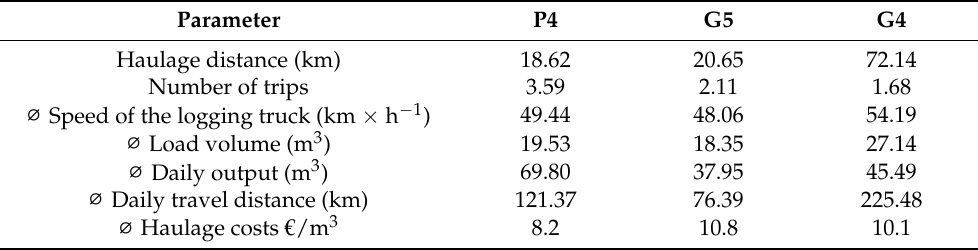
Table 3. Mean values of selected operational parameters of the Scania P450 (P4), G500 (G5), and G440 (G4) logging trucks.